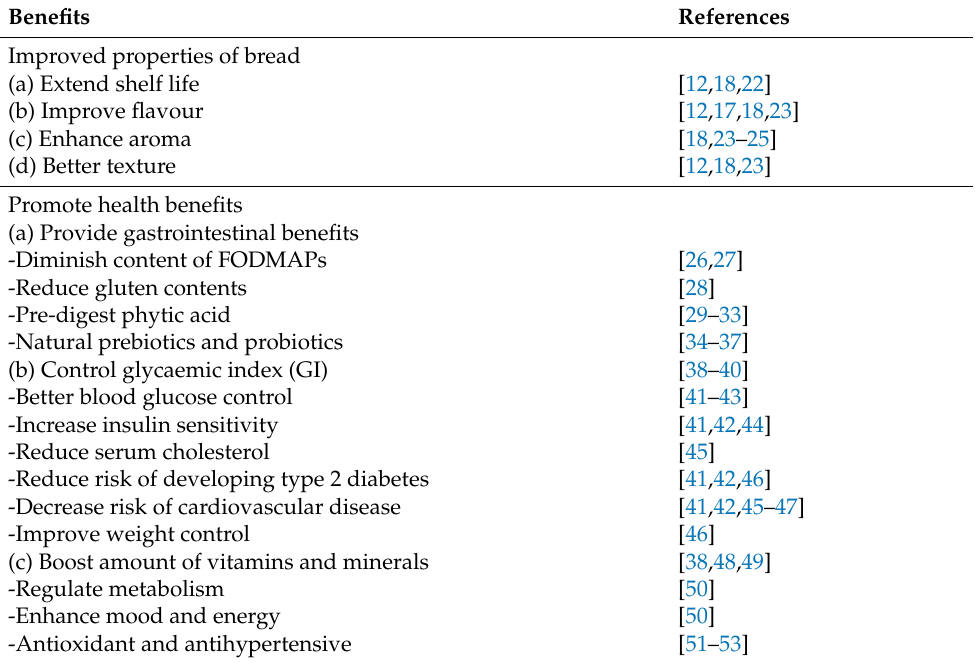
Figure 1. A mind map guide to sourdough. Table 1. Benefits of sourdough as shown in Figure 1.